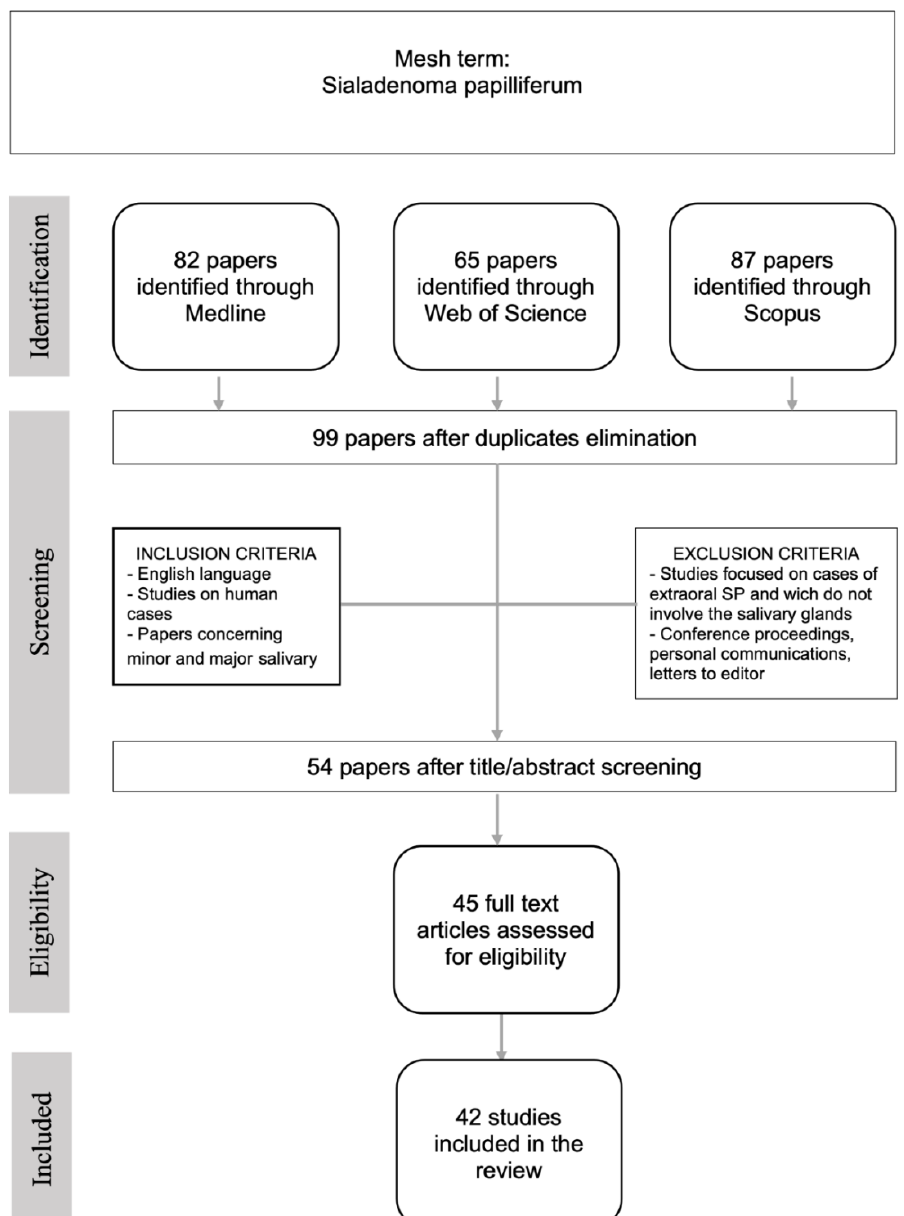
Scheme 1. Flow chart diagram for the selection of 42 papers included in the